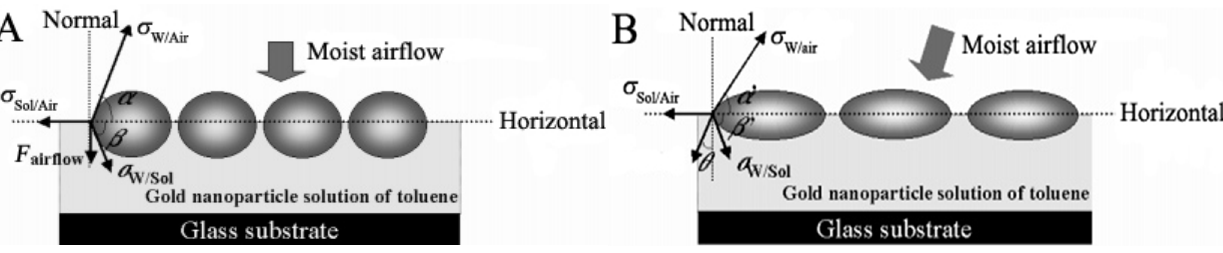
Figure 10. Models of water droplets as templates to form circular pores ( A ) or elliptic pores ( B ), with copyright permission from